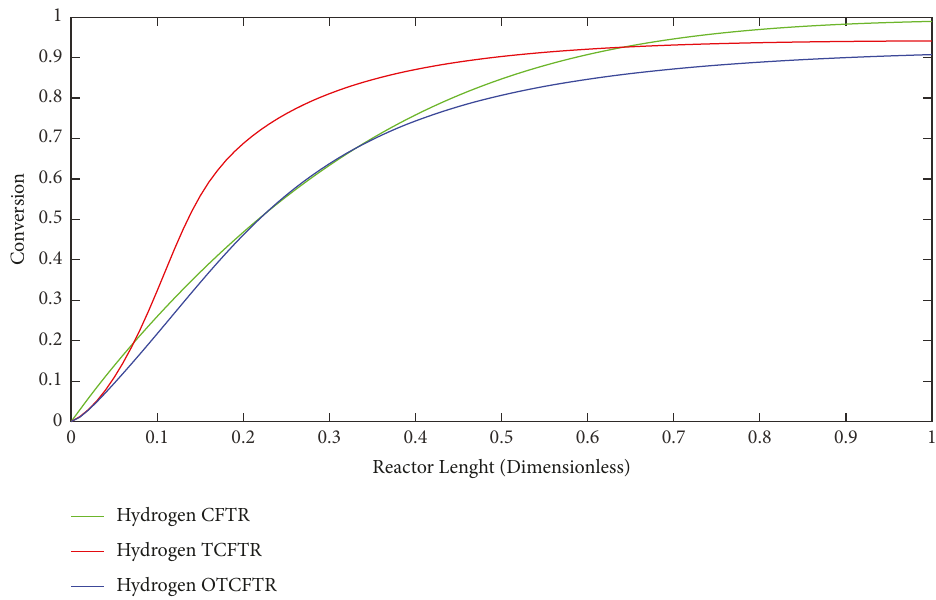
Figure 24: Conversion percentage of hydrogen in various modes along the reactor length.